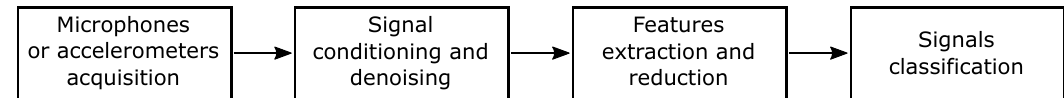
Figure 1. Typical workflow for vibroacoustic signal analysis and classification. First, the sound is acquired inside or outside the hive using microphones or accelerometers. Then, the recorded signal is usually filtered or resampled to remove noise and unwanted frequencies; then, features are extracted from the signal, exploiting different algorithms. If necessary, a features reduction process is applied, based on algorithms such as Principal Component Analysis (PCA). Finally, the data are passed to a classification algorithm to detect the colony health status: typical classifiers are based on Support Vector Machine (SVM), Linear Discriminant Analysis (LDA), and Machine Learning